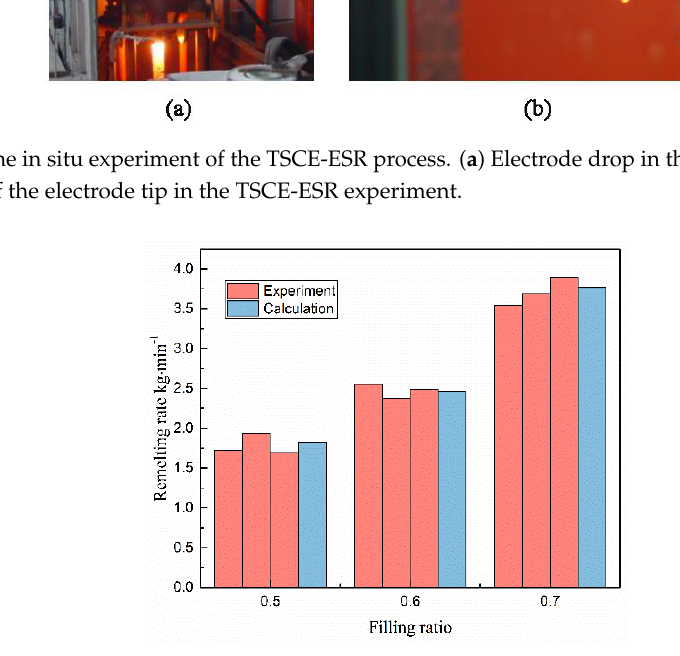
Figure 6. Comparison between the measured value and the calculated value of the remelting rate.